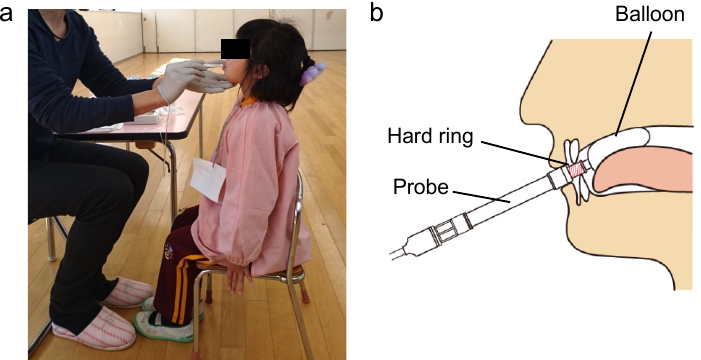
Figure 1. Methods of tongue pressure measurement. ( a ) Children’s posture when measuring tongue pressure. ( b ) Intraoral position of the balloon during tongue pressure measurement.